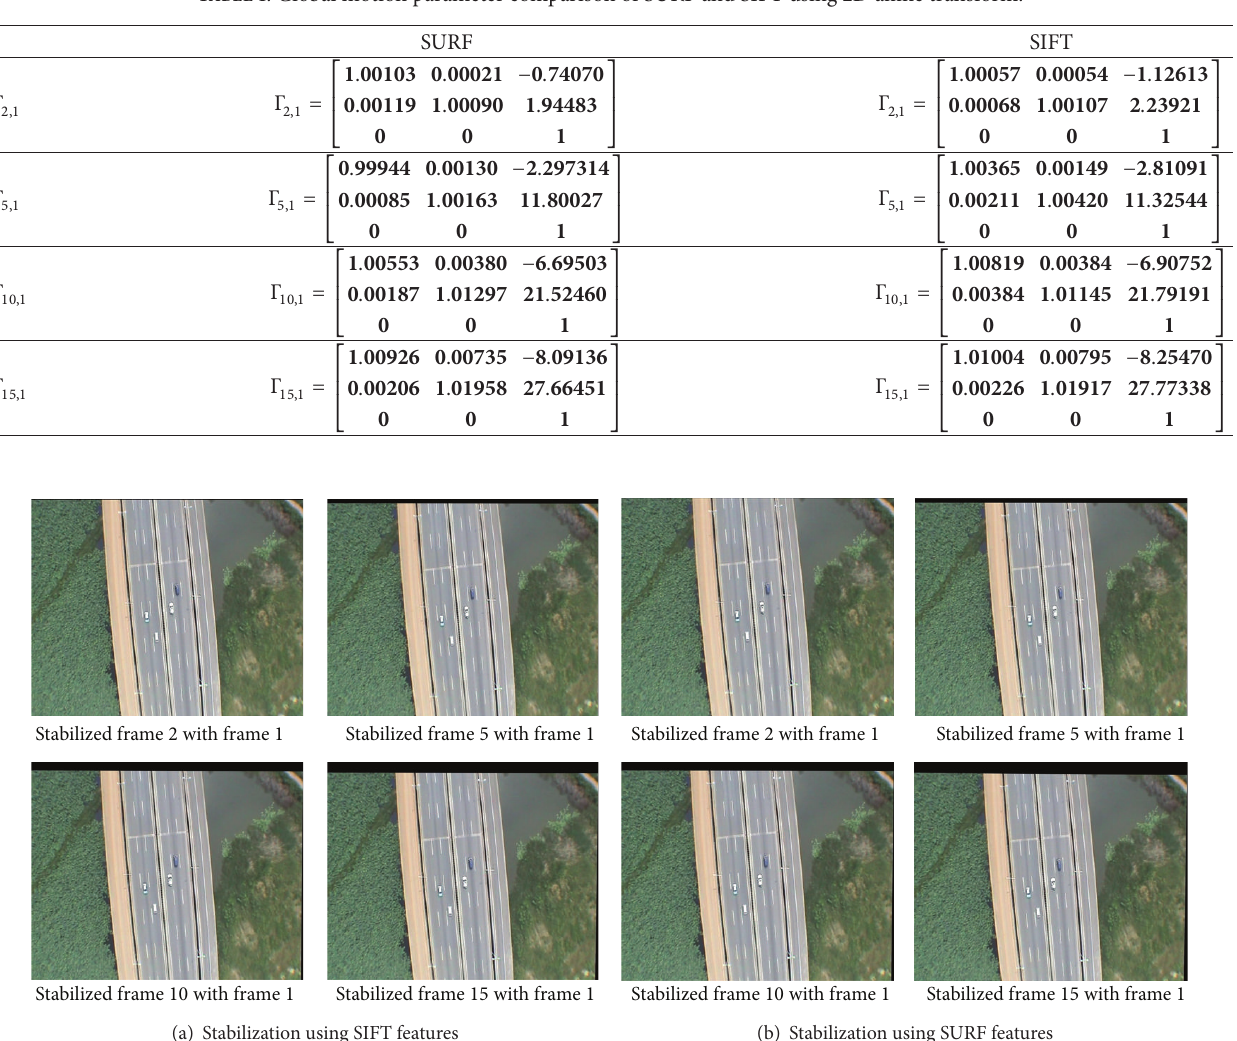
Table 1: Global motion parameter comparison of SURF and SIFT using 2D affine transform.